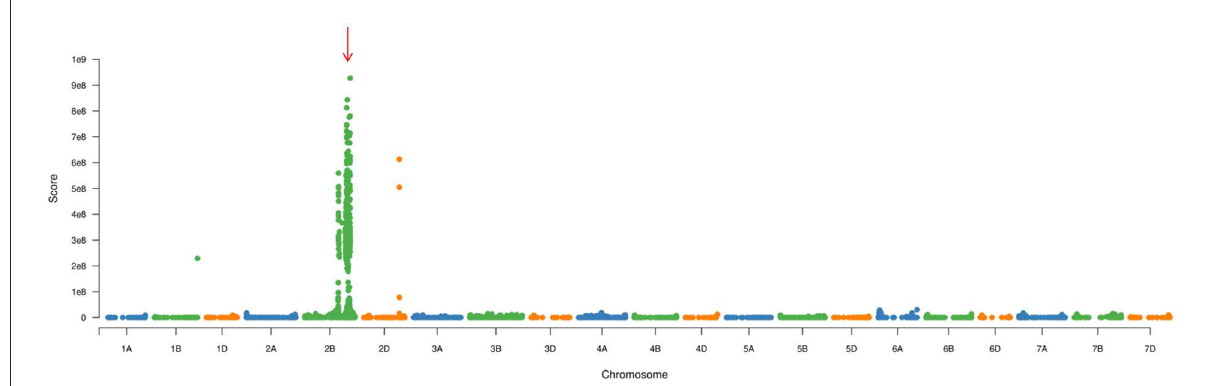
FIGURE2 Manhattan plot of the varBScore across the 21 wheat chromosomes for analyzing the candidate region (indicated with red arrow).